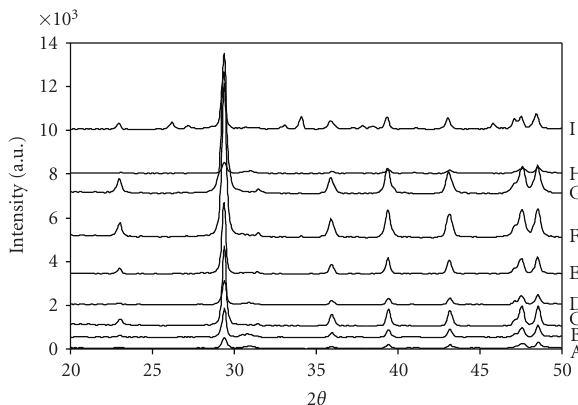
Figure 4: E ff ect of di ff erent experimental conditions on X-ray di ff raction spectra. A: Without orifice, 4% Ca(OH) 2 slurry, 5 l/min CO 2 flow rate; B: 1mm orifice, 4% Ca(OH) 2 , slurry 5l/min CO 2 flow rate; C: 2mm orifice 4% Ca(OH) 2 , slurry 5l/min CO 2 flow rate; D: 3mm orifice 4% Ca(OH) 2 slurry 5 l/min CO 2 flow rate; E: 4mm orifice 4% Ca(OH) 2 , slurry 7 l/min CO 2 flow rate; F: 4mm orifice 2% Ca(OH) 2 , slurry 5l/min CO 2 flow rate; G: 4 mm orifice 6% Ca(OH) 2 slurry, 5 l/min CO 2 flow rate; H: 4mm orifice 4% Ca(OH) 2 slurry, 3 CO 2 l/min flow rate; I: 4mm orifice, 4% Ca(OH) 2 slurry, 5CO 2 l/min flow